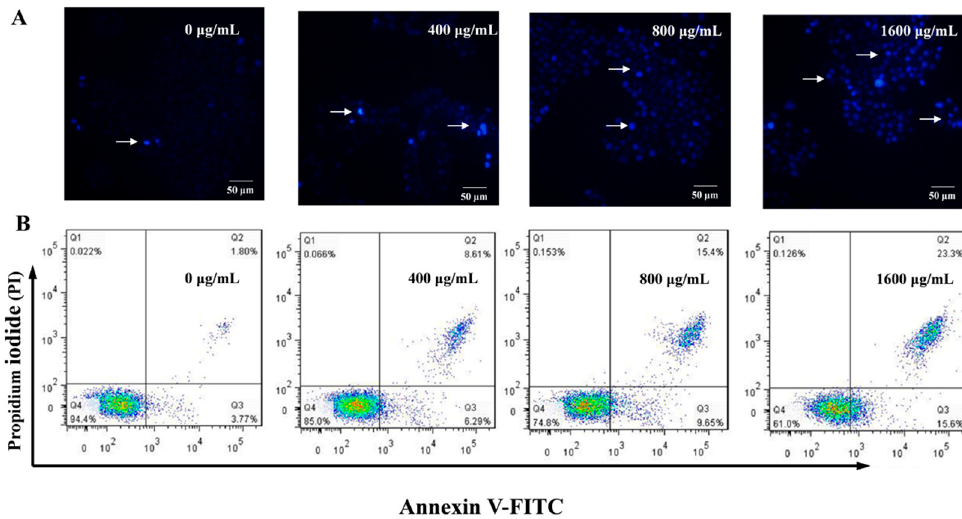
Figure 6. Effect of AMEP-2 on the apoptosis of BGC-823 cells: ( A ) Hoechst 33258 staining. BGC-823 cells were treated with 0, 400, 800 and 1600 µ g/mL AMEP-2 for 48 h, Bar = 50 µ m; and ( B ) Annexin V/PI dual staining of BGC-823 cells. BGC-823 cells were treated with 0, 400, 800 and 1600 µ g/mL AMEP-2. Apoptosis was also detected through an Annexin V-FITC/PI double-staining assay. As